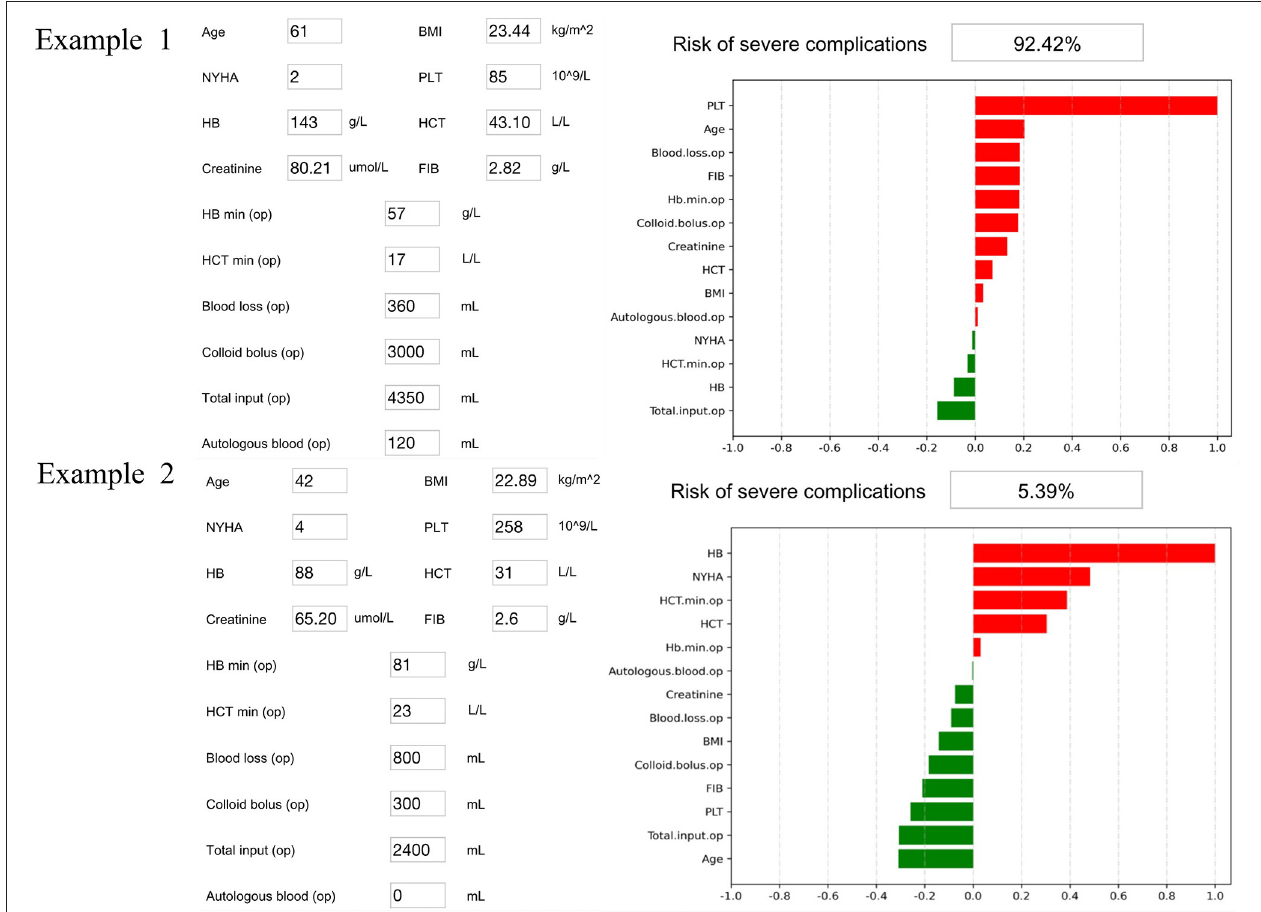
FIGURE 4 | Two examples of website tool usage. Enter the values of 14 key variables to predict the risk of severe complications and show the contribution of each value to the outcome. Example 1 has a higher risk of severe complications, and example 2 may have a better prognosis.